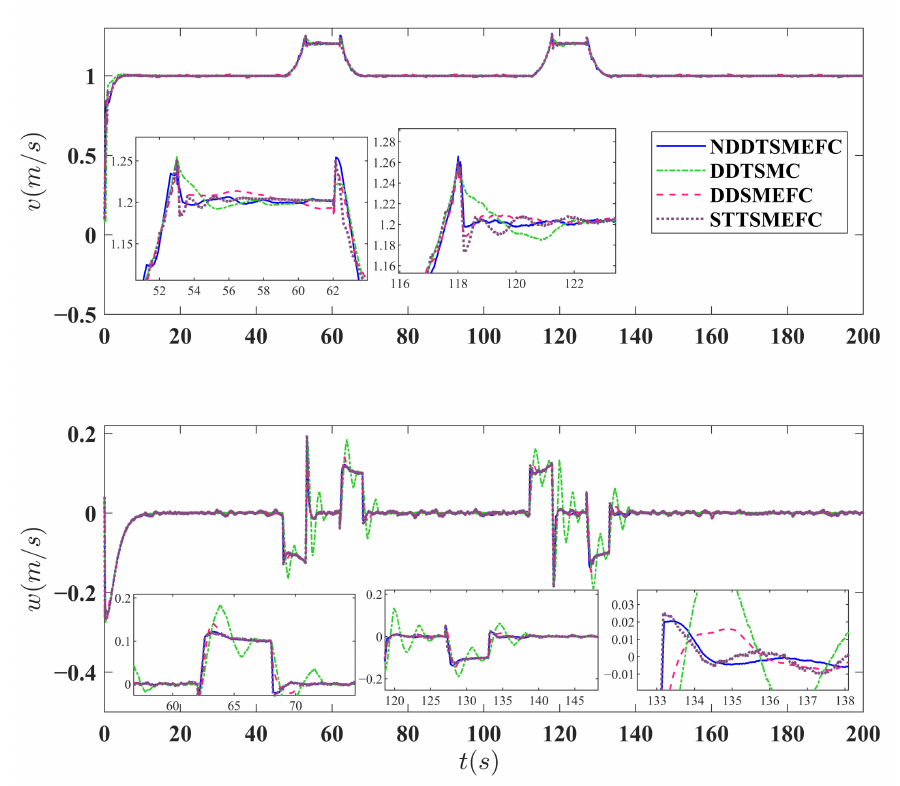
Figure 10. Schematic diagram of UTROV system output (Velocity).